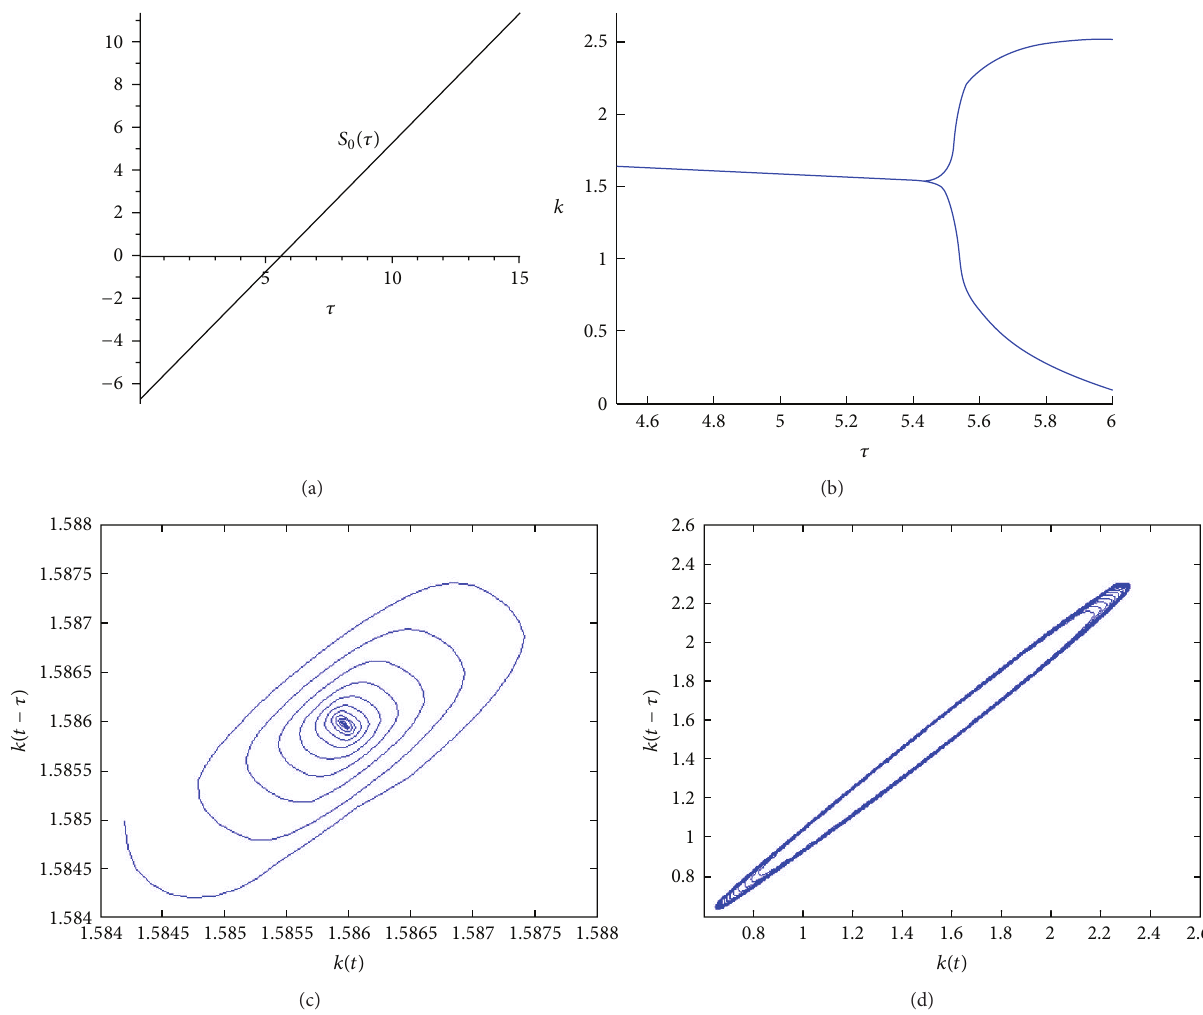
Figure 1: (a) Graph of stability switch in terms of time delay if 𝑛 < 0 (parameter specification (26)); (b) associated bifurcation diagram; (c) phase plane for 𝜏 = 5 ; and (d) phase plane for 𝜏 = 5.6 .